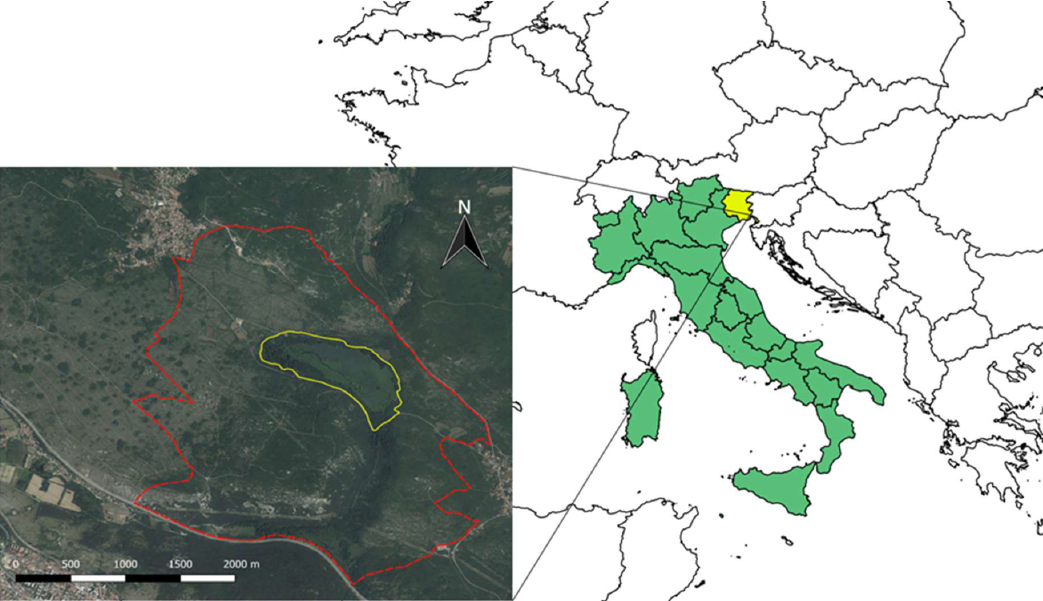
Figure 1. Location of the study area (yellow border) within the Regional Natural Reserve “Laghi di Doberdò e Pietrarossa” protected area (red dashed border).